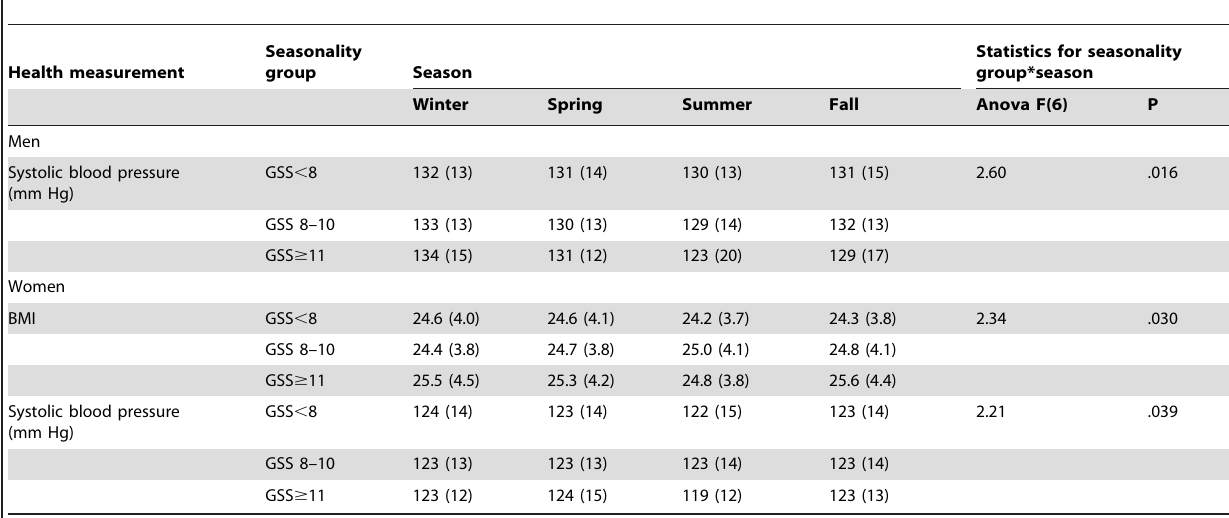
Table 3. Effect of season on the associations between high seasonality and objective health risk